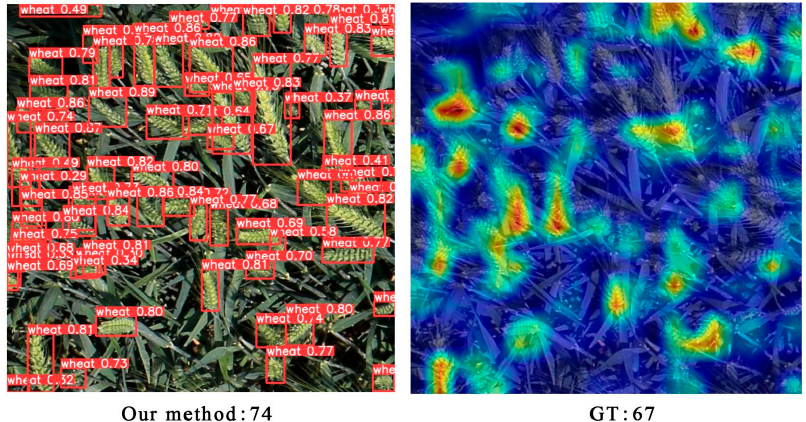
Figure 15. The comparison between the ground truth and the counting with our method. GT: ground truth .